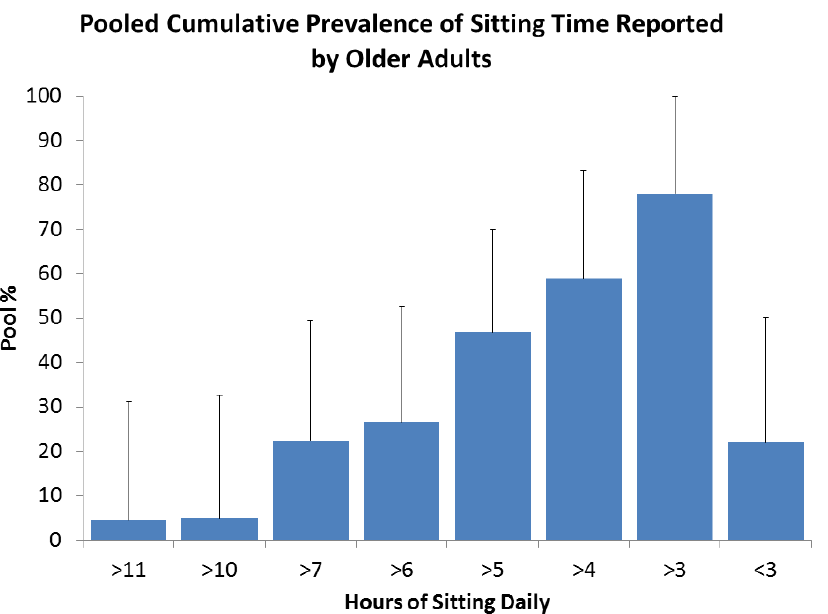
Figure 3. Meta-Prevalence of sitting, N = 372,550 older adults, n = 7 from six countries, note time categories of <3 h (22%) and >3 h (78%) is equal to